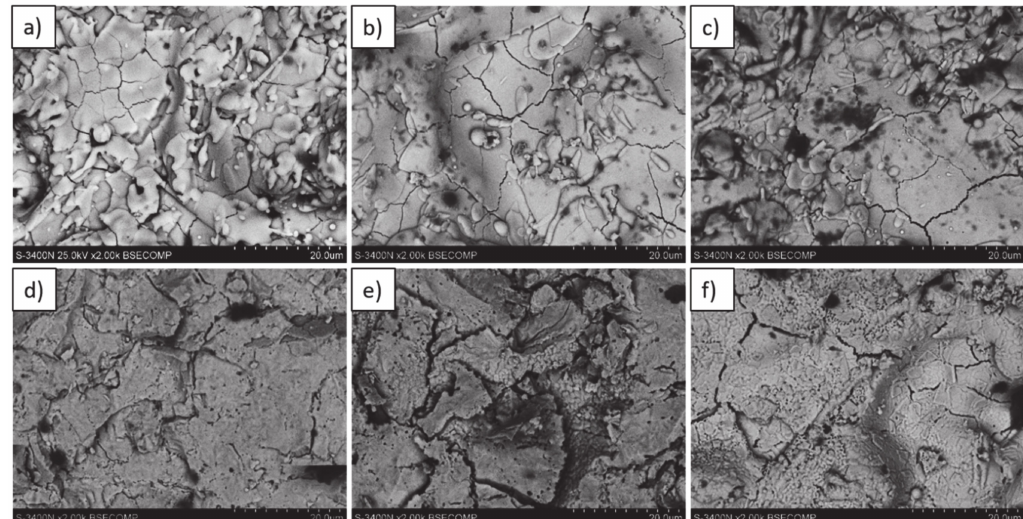
Figure 31. Top-coat topography in as-sprayed conditions (top) and after oxidation test (bottom): ( a , d ) monolayered La 2 Zr 2 O 7 , ( b , e ) composite 50% La 2 Zr 2 O 7 + 50% 8YSZ, and ( c , f ) DCL La 2 Zr 2 O 7 / 50% La 2 Zr 2 O 7 + 50% 8YSZ /